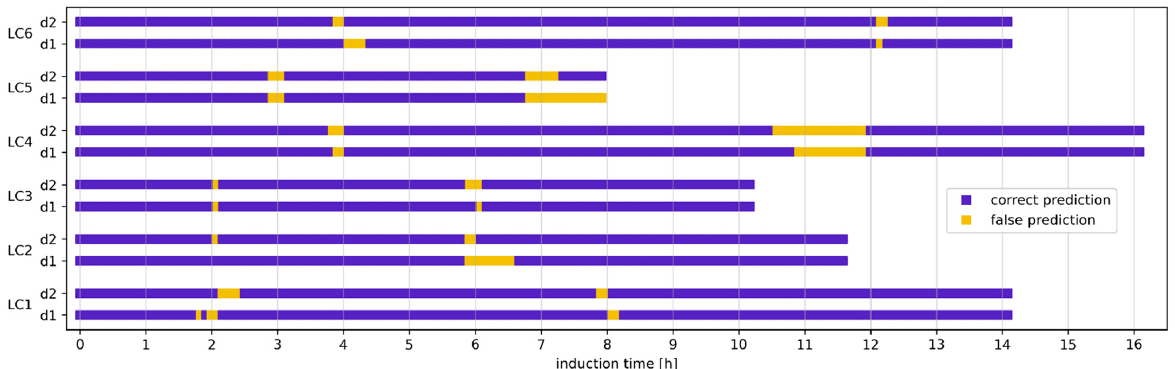
Figure 7. Correct and false classifications of the random forest classifiers (RFCs) in the time domain. Models were evaluated with the first and second derivatives (d1 and d2) of baseline-corrected post-induction spectra. The pruning parameter was set to 0.06.